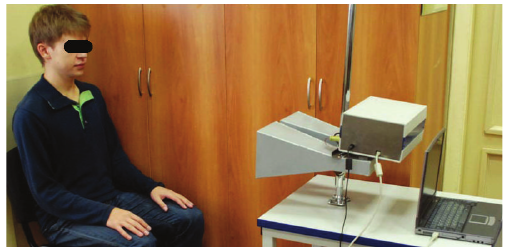
Figure 1: Sketch of the experimental setup.